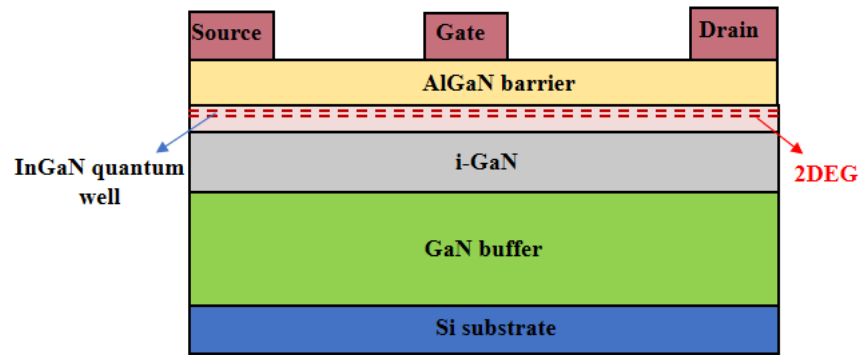
Figure 1. AlGaN/InGaN/GaN HEMT